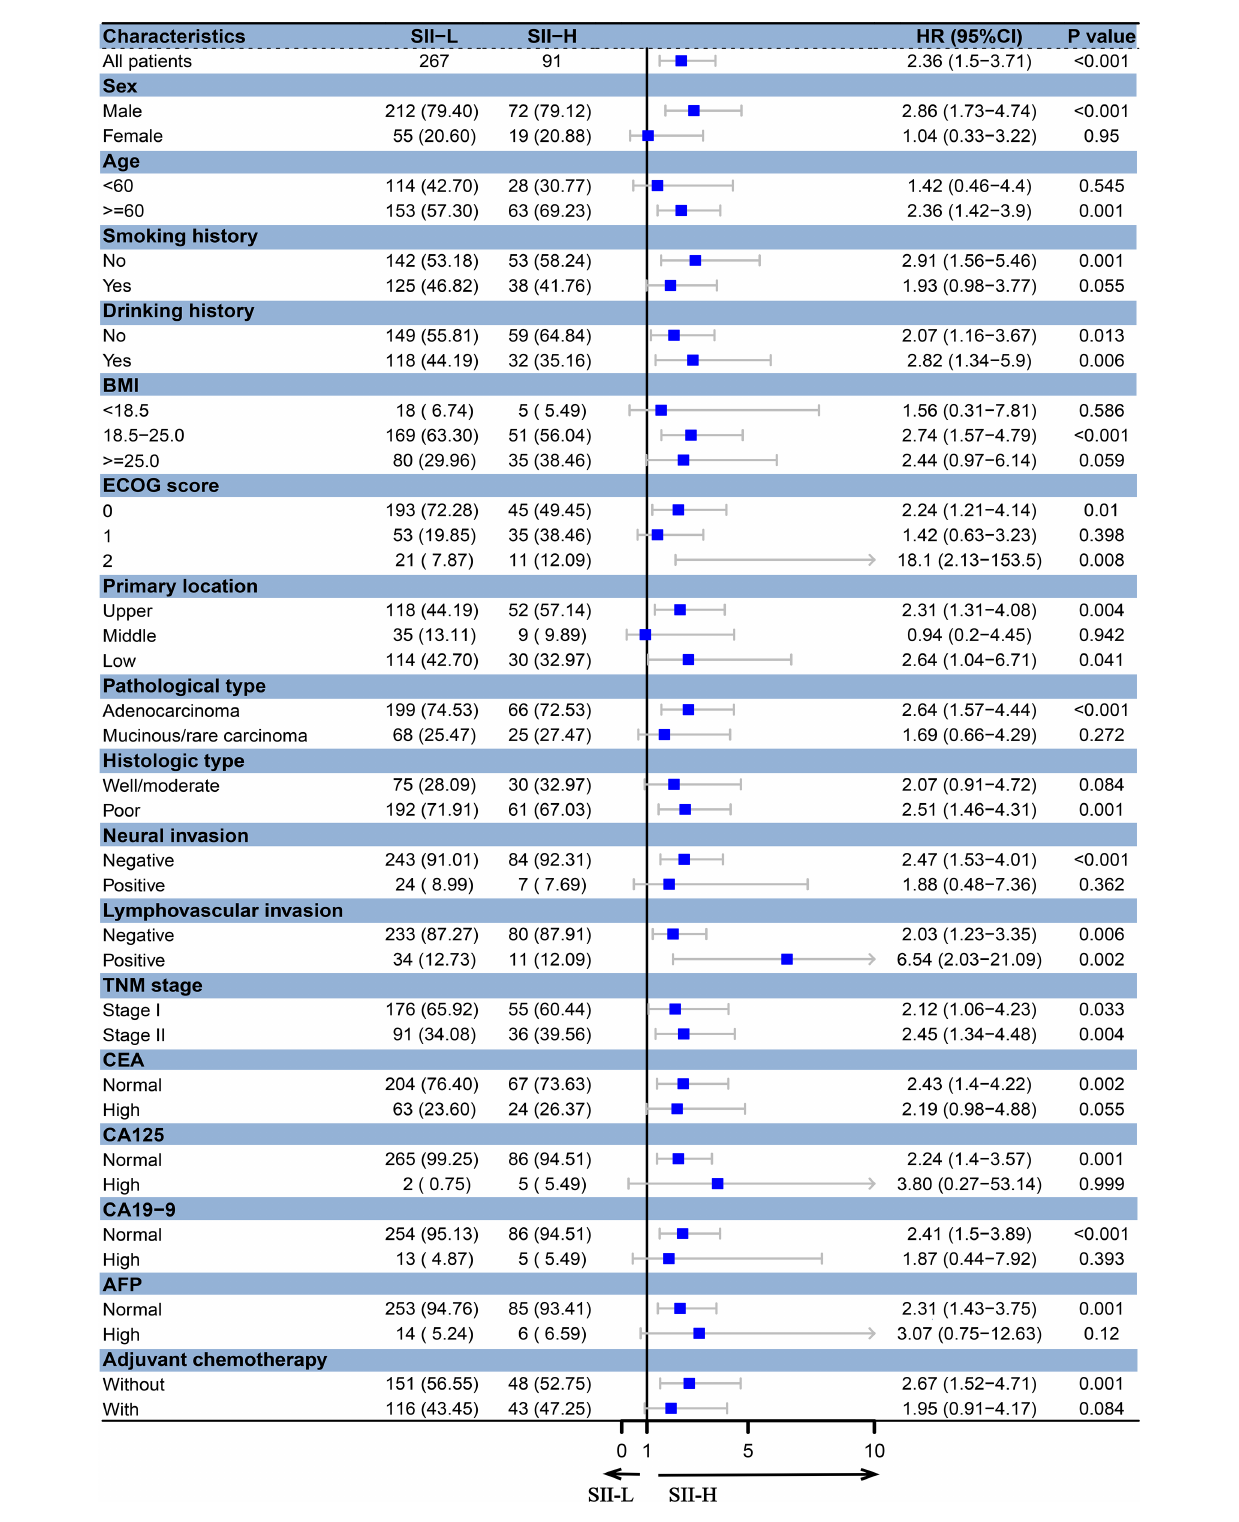
Frontiers in Oncology |